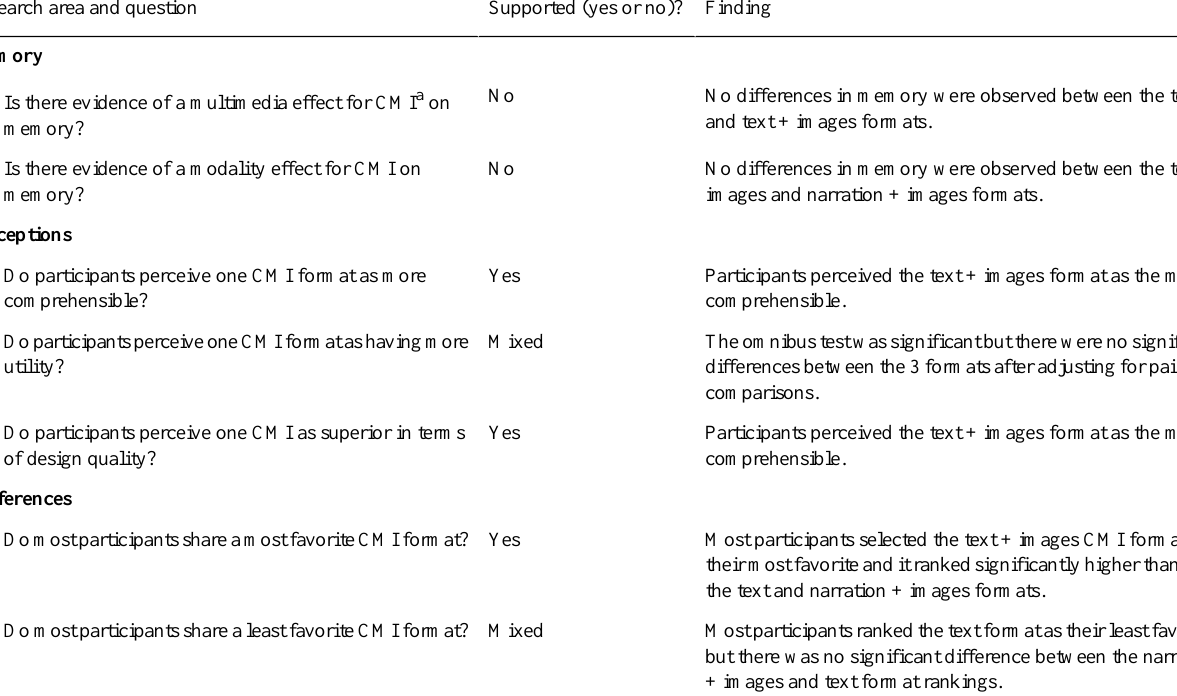
Table 3. Summary of research areas, questions, and